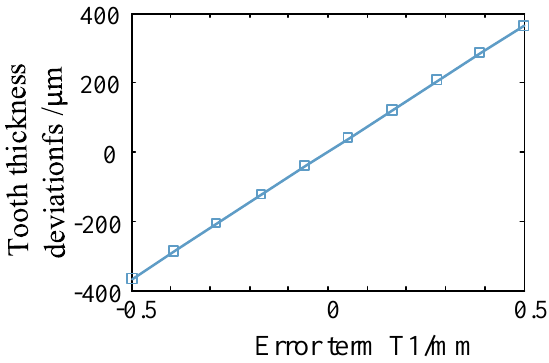
Figure 11. Relationship between tooth thickness deviation and T1.